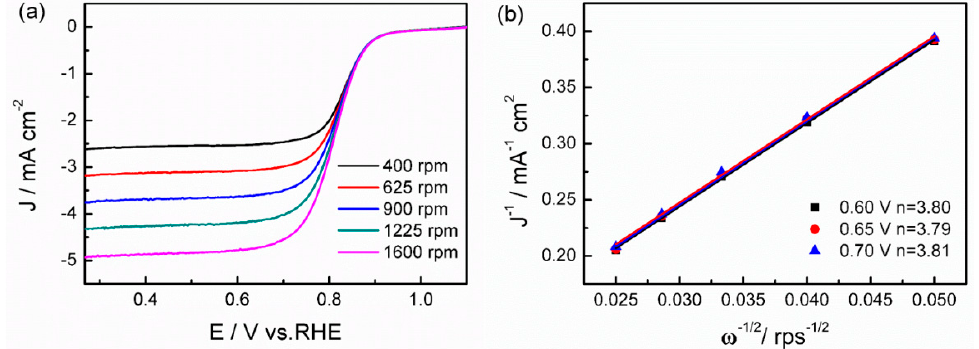
Figure 7. ( a ) RDE polarization curves for ORR on Pt NCs/CNTs-10% at different rotation speeds from 400 to 1600 rpm in O 2 -saturated 0.1 M HClO 4 solution at 10 mV s –1 and ( b ) Corresponding K-L plot at different potentials.